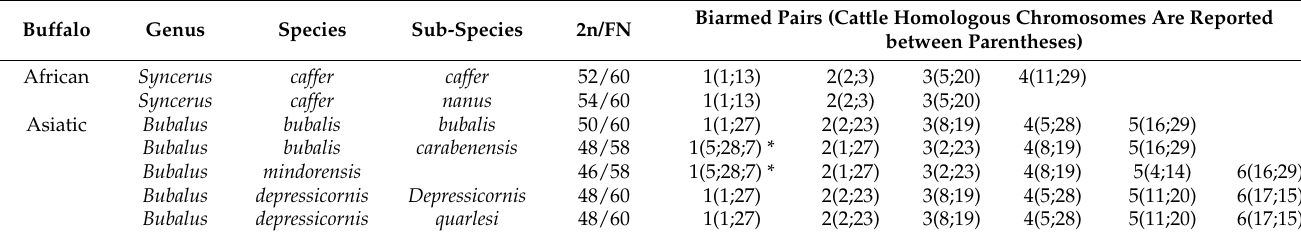
Table 1. Diploid number (2n), fundamental number (FN), and cattle homologous chromosomes (ancestral bovid karyotype) involved in the autosomal biarmed pairs of both African ( Syncerus ) and Asiatic ( Bubalus ) buffaloes according to [47,52,62,65]. Buffalo Genus Species 2n/FN